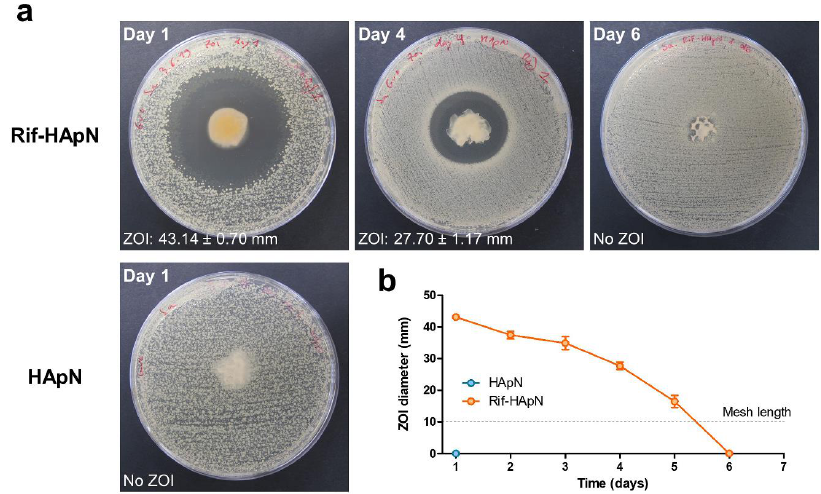
Figure 3. In vitro performance of Rif-HApN against Sa. ( a ) Macroscopic pictures of the zones of inhibition (ZOIs) developed by Rif-HApN in the agar plates at selected time-points (days 1, 4 and 6). As expected, drug-free HApN did not exert any antibacterial activity. ( b ) Measurement of the ZOIs revealed a strong, sustained antibacterial effect of the meshes coated with the Rif-HApN hydrogel (n = 3) that lasted for 5 days.